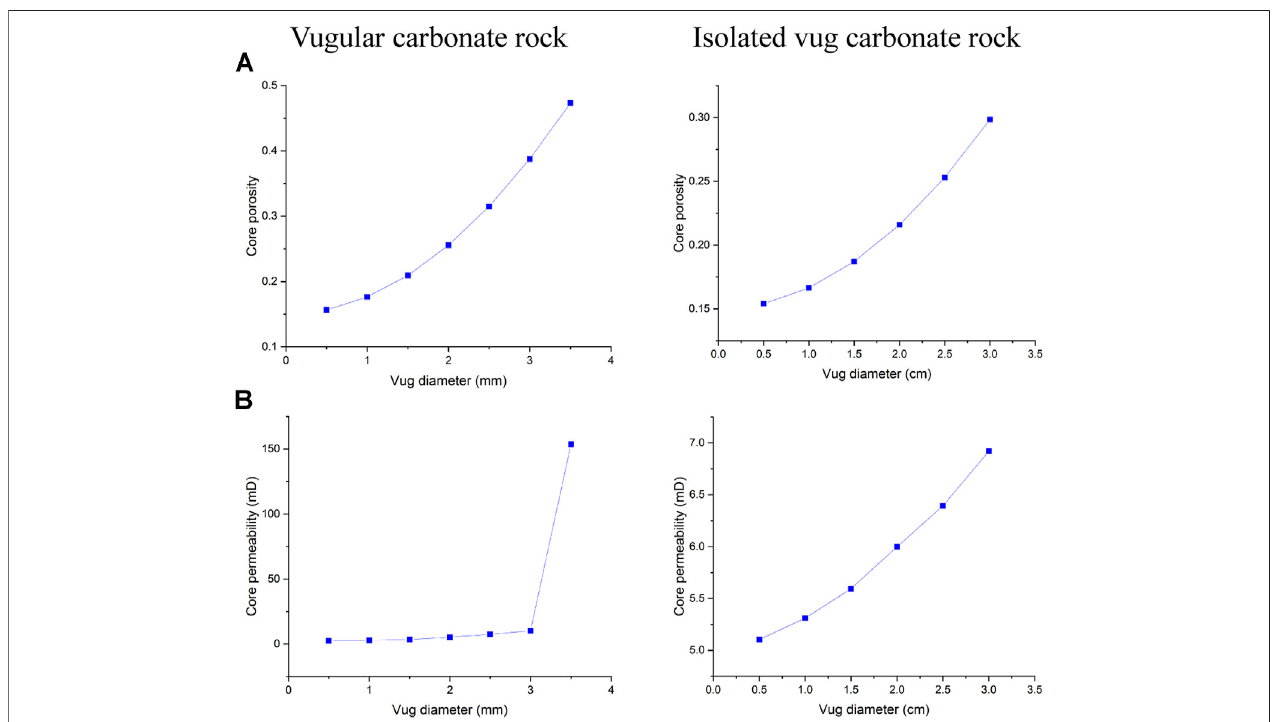
FIGURE 10 | Effect of vug diameter on core physical parameters: (A) core porosity and (B) core permeability.